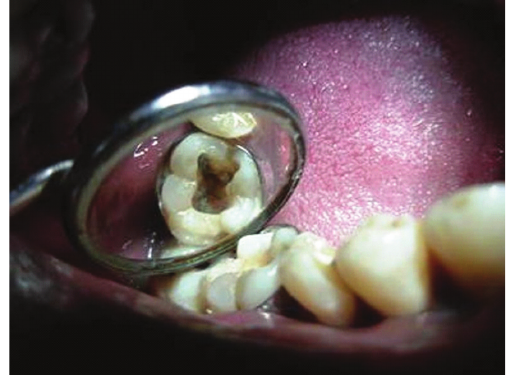
Figure 2: Splinting with orthodontic band.